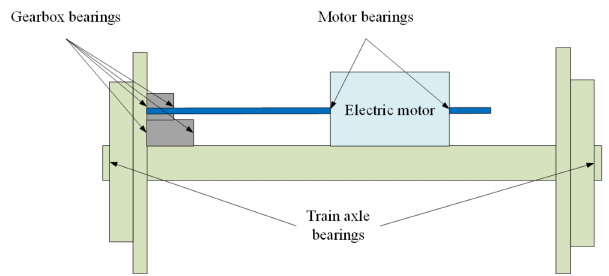
Figure 11. The distribution position of bearing sensors on the bogie.